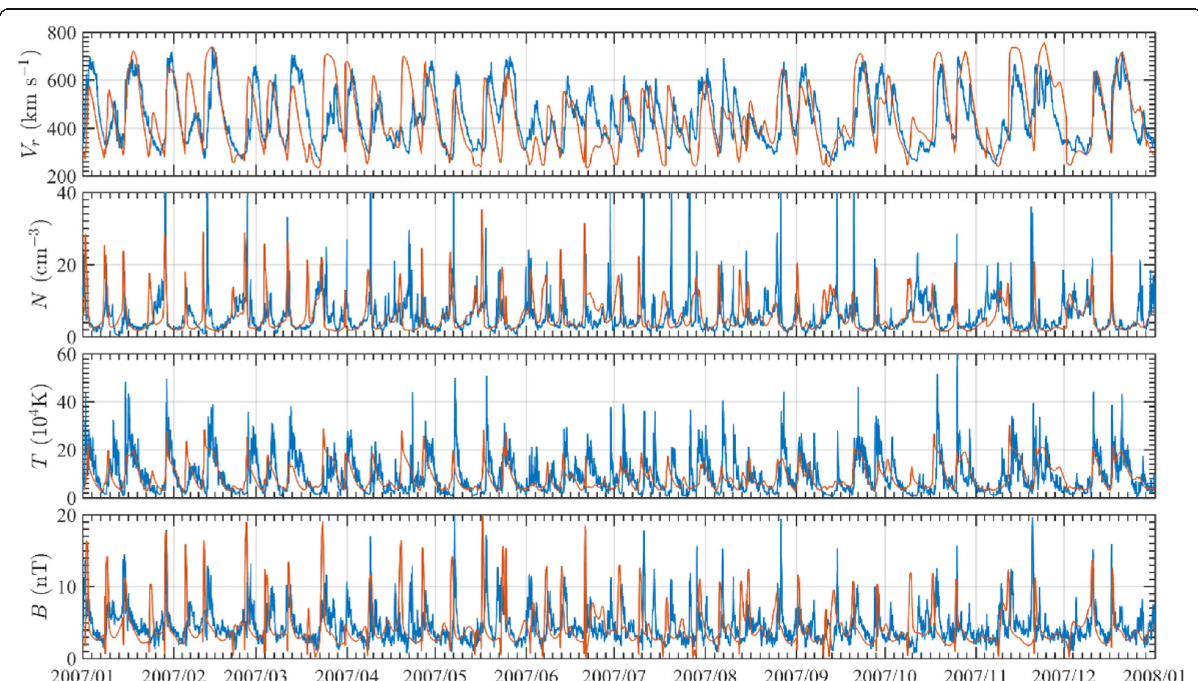
Fig. 11 Modeled (red lines) and observed (blue lines) time profiles of solar wind parameters at 1.0 au through all of 2007. From the top to the bottom, the panels show the speed V r , number density N , temperature T , and total magnetic field strength B (From Shen et al. 2018b). Besides the improvement in the treatment of the inner boundary condition, there have been significant improvements in other aspects of background solar wind simulations in recent years. Some of these are detailed